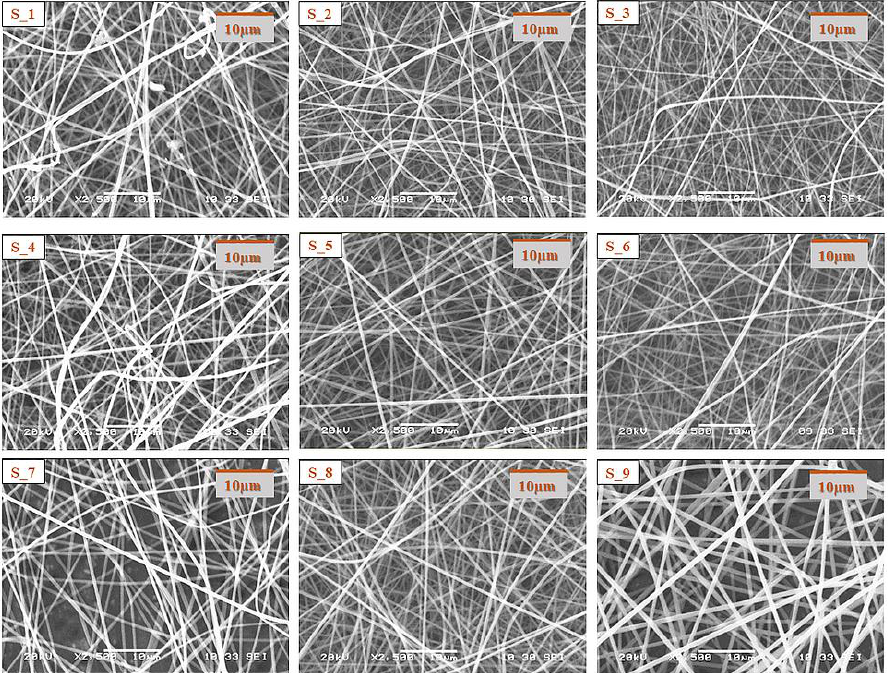
Figure 2. SEM images of electrospun samples prepared from different composition shell precursor solutions (magnification: 2500 × ).